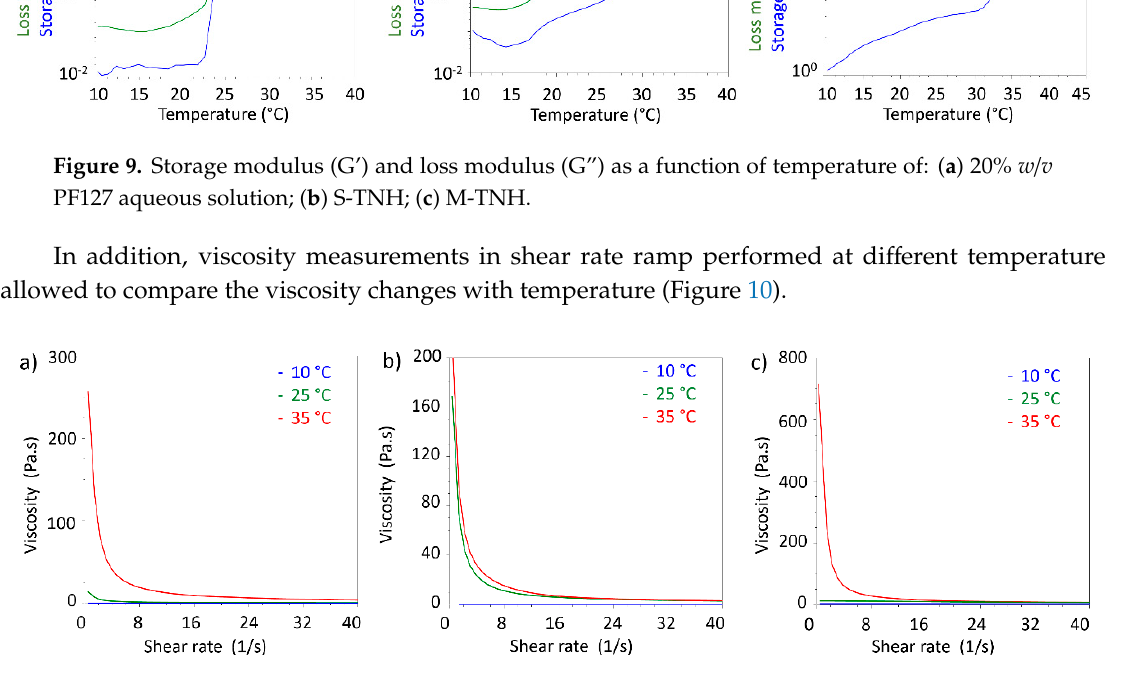
Figure 10. Viscosity curve of: ( a ) 20% w/v PF127; ( b ) S-TNH; ( c ) M-TNH at different temperatures (10, 25, 35 °C).